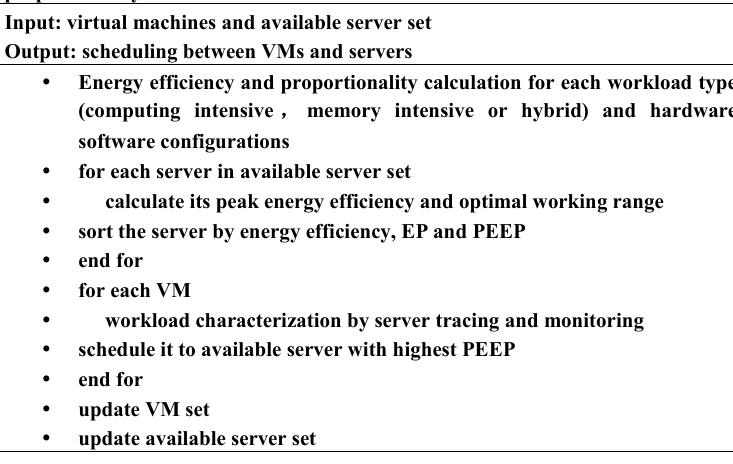
Algorithm 1: Virtual machine scheduling algorithm based on energy efficiency and